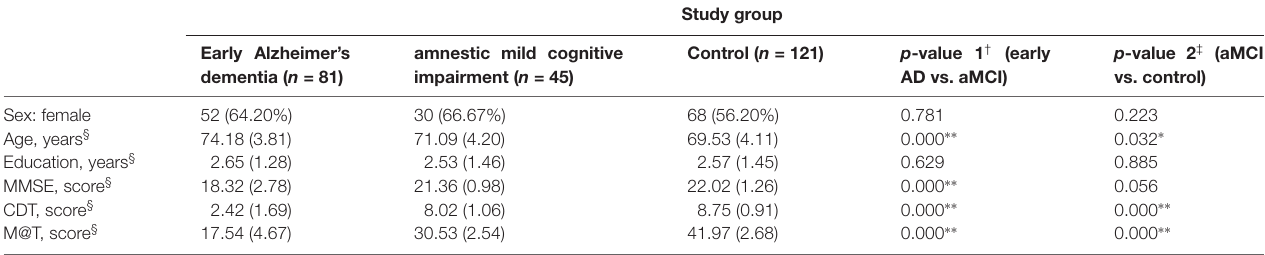
TABLE 1 | Demographic characteristics and cognitive test scores in 247 low-level education individuals from Lima-Peru, according to definitive diagnosis.